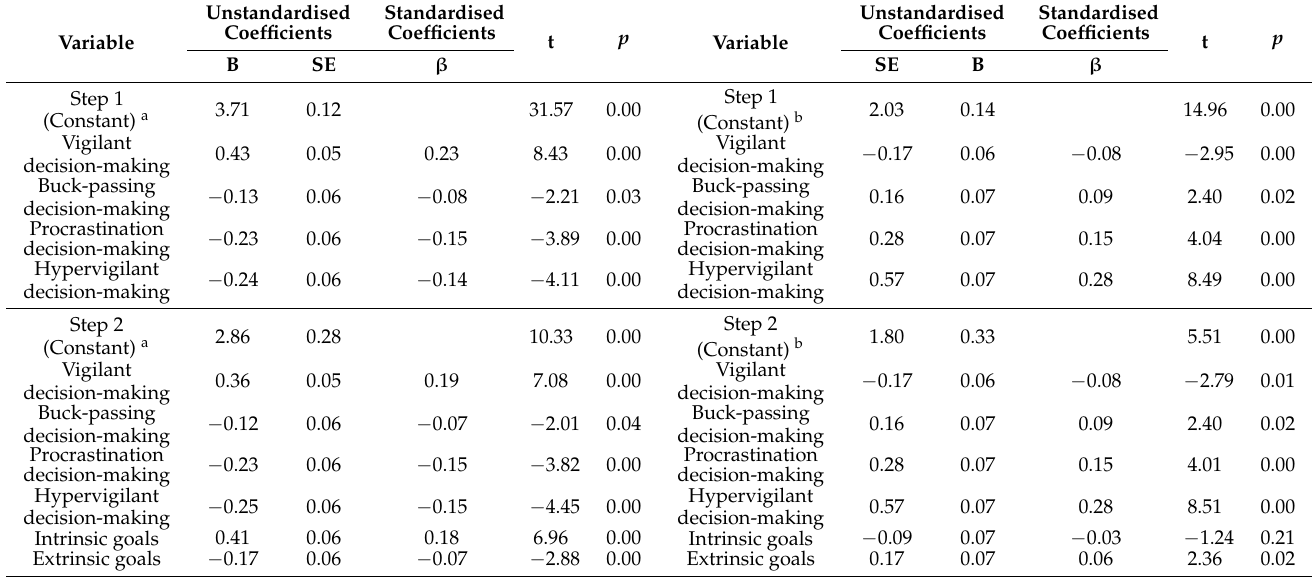
Table 4. Hierarchical regression analyses for Autonomy Satisfaction a and Frustration b